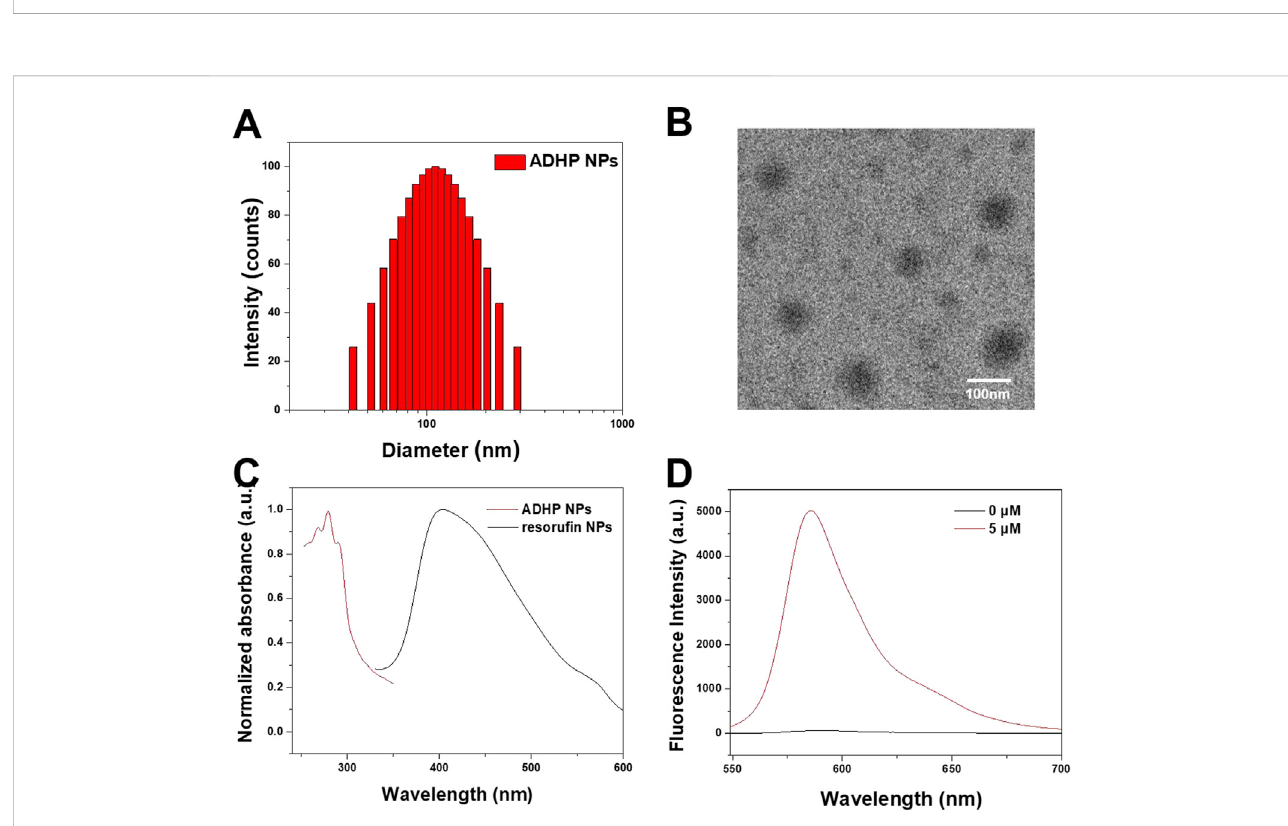
FIGURE 3 (A) DLS pro fi le of ADHP NPs. (B) Representative transmission electron microscopy images of the ADHP NPs. (C) Absorbance spectra of ADHP NPs and resoru fi n NPs. (D) Fluorescence spectra of ADHP NPs (concentration 0 and 5 μ M) after responding with H 2 O 2